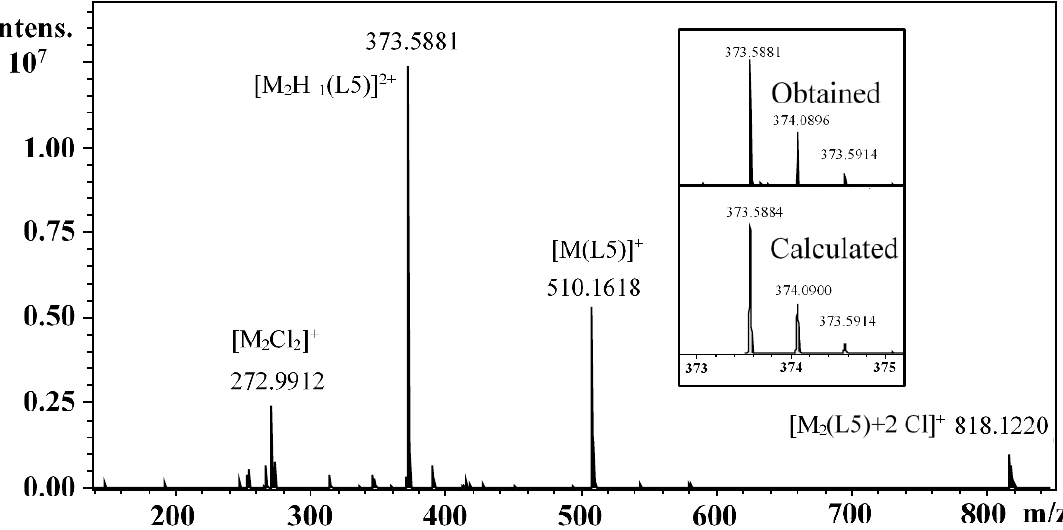
Figure 12. HR-ESI-TOF-MS spectrum registered in the [( η 5 -Cp*)Rh] 2+ –L5 system at 2:1 metal-ion-to-ligand-ratio, pH = 3.7. Figure 12. HR - ESI-TOF-MS spectrum registered in the [(η 5 -Cp*)Rh] 2+ –L5 system at 2:1 metal-ion-to-ligand-ratio, pH = 3.7. Inlet shows the observed and calculated isotope pattern for [M 2 H –1 L] 2+ . Inlet shows the observed and calculated isotope pattern for [M 2 H –1 L] 2+